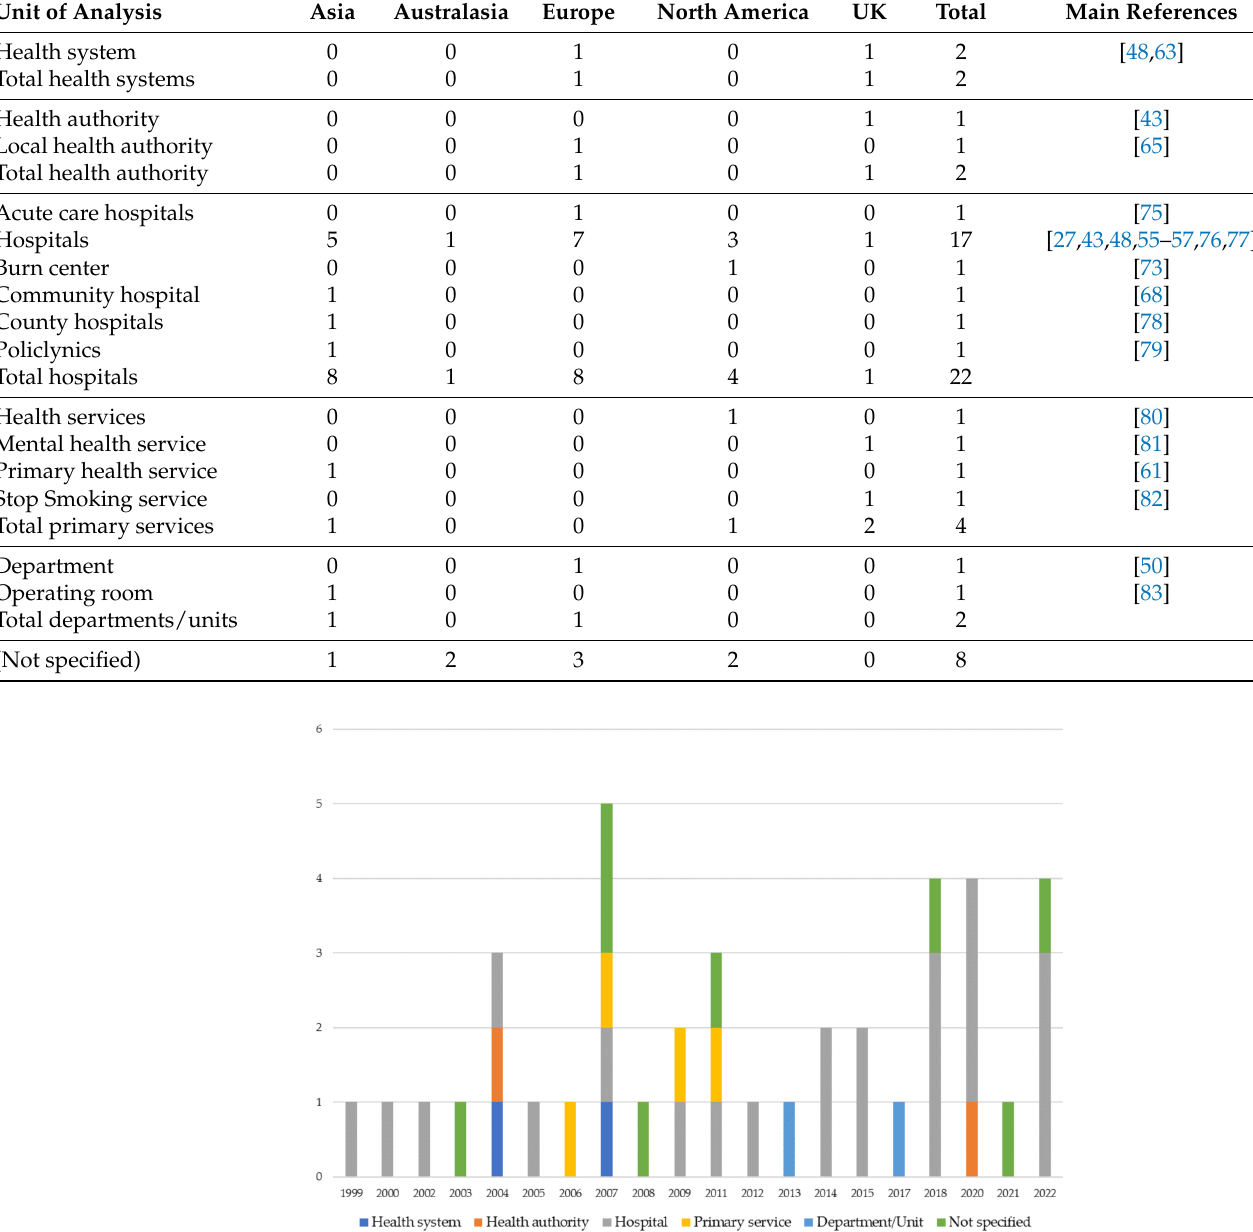
Figure 7. Distribution of papers by units of analysis and